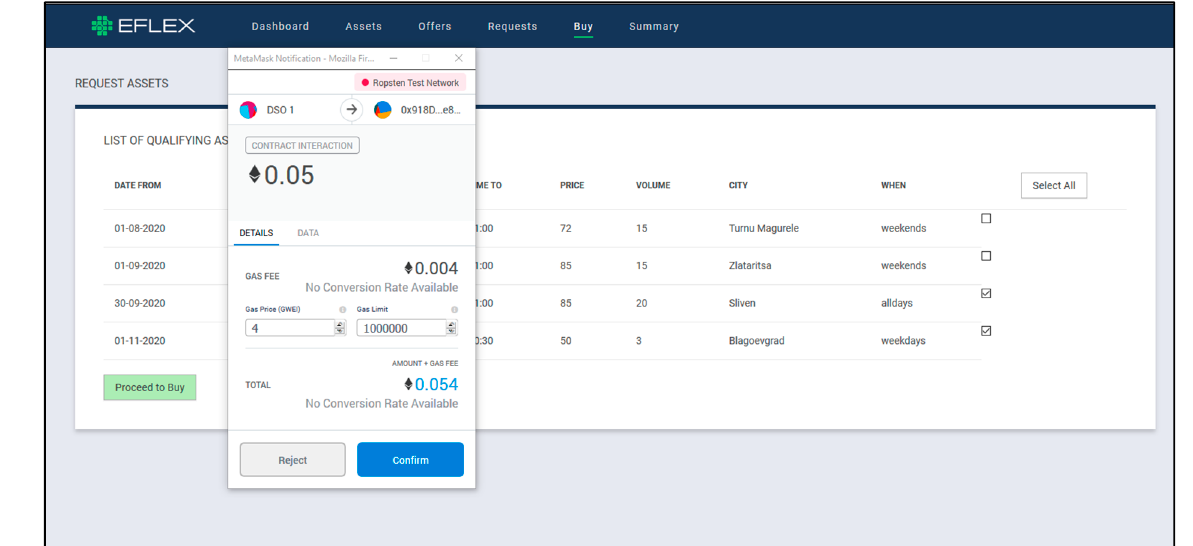
Figure 22. Blockchain-based wallets to facilitate micro-payments between buyers and sellers.